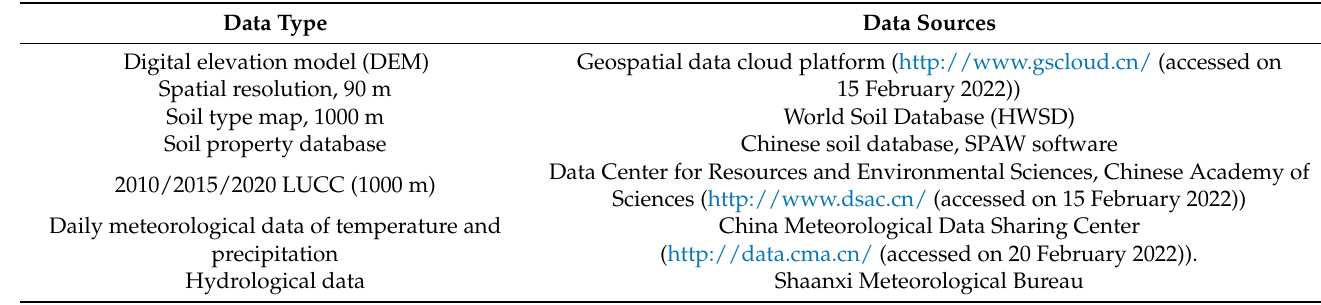
Table 2. Attribute data required for SWAT model construction and their